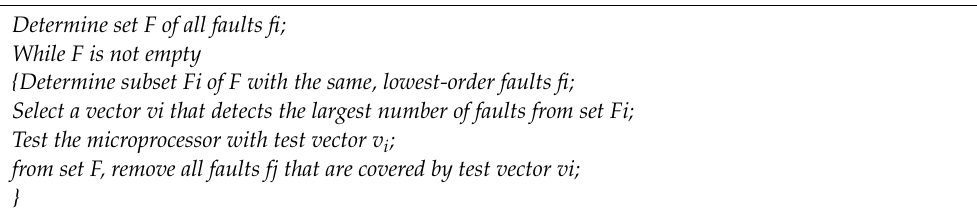
Algorithm 3: Hybrid (improved the lowest-order vector